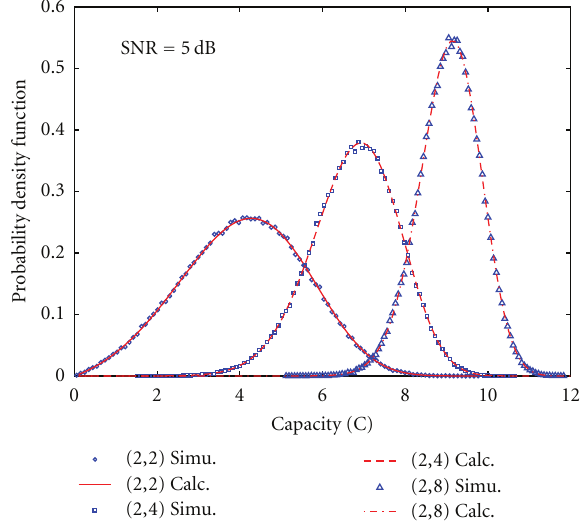
Figure 3: Comparison between simulation and calculation results for distributions of capacities of GMD-based transceivers in (2,2), (2,4), and (2,8) MIMO Rayleigh fading channels. Assuming γ = 5dB.